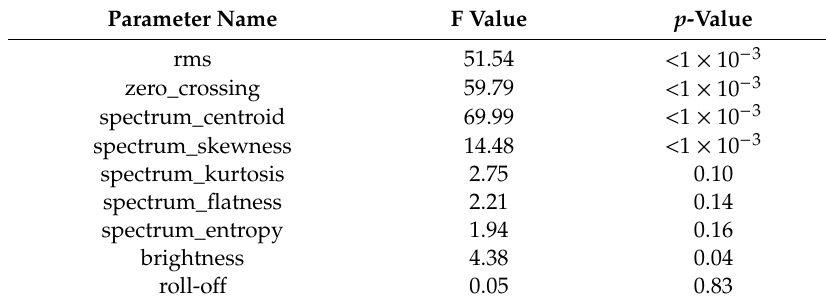
Table 2. ANOVA analysis illustrating the influence of the investigated parameters on the genre